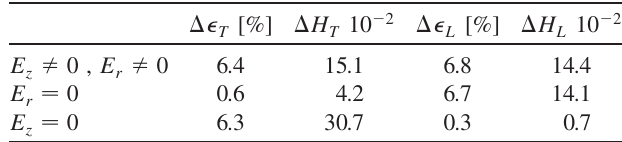
TABLE XIV. Effect of each field component ( v ¼ 340 kV ), Gaussian.